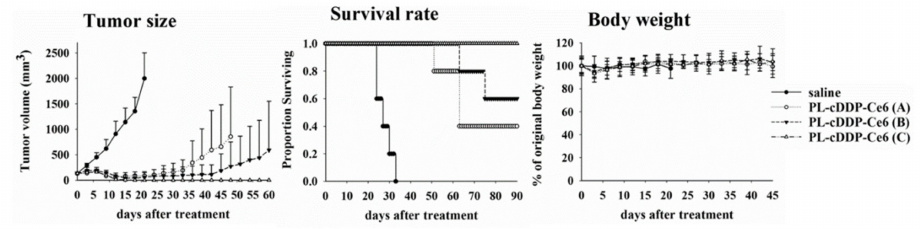
Figure 3. Therapeutic outcome of PL-cDDP-Ce6 in human S462-TY xenograft tumor-bearing mice. Mice were injected with one dose of PL-cDDP-Ce6 and received two dose of light irradiation (100 J / cm 2 ) at 2 and 12 h post-drug administration, respectively. The dose of cDDP administrated in mice was 3.5 mg / kg and the dose of Ce6 varied under the doses of 1 (A), 1.25 (B) and 1.5 mg / kg (C). Left panel, tumor size; Middle panel, survival rate; Right panel, body weight. The presented data are mean ± S.D. for each group (N =